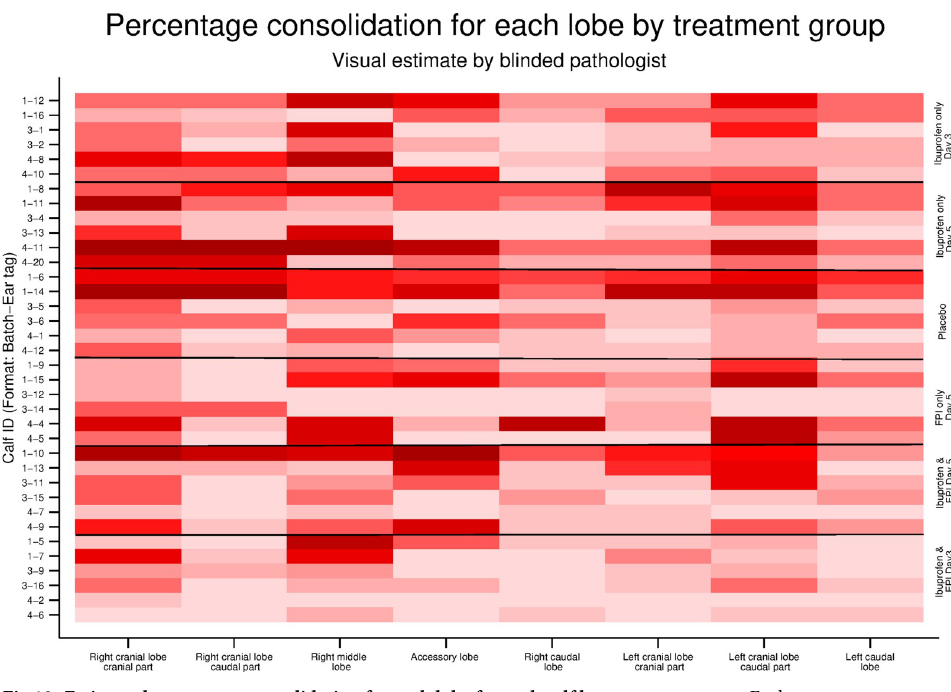
Fig 10. Estimated percentage consolidation for each lobe for each calf by treatment group. Each row represents a single calf. Each column represents a lobe. Darker shading means more and lighter shading less